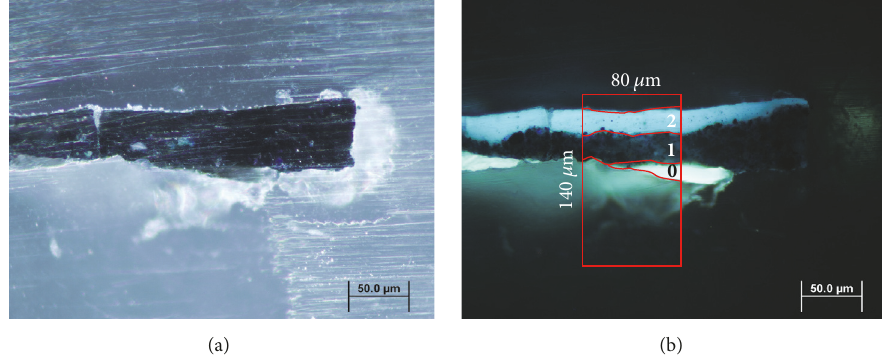
Figure 1: Cross-section microphotographs of sample 15r1 embedded in KBr. (a) Image under visible light; (b) image under UV illumination; the red box indicates the selected area for 𝜇 FTIR-ATR